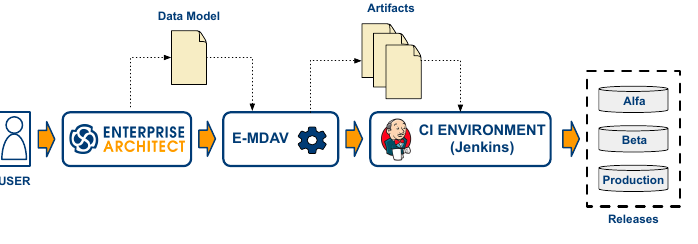
Figure 11. E-MDAV in a DevOps CI pipeline.